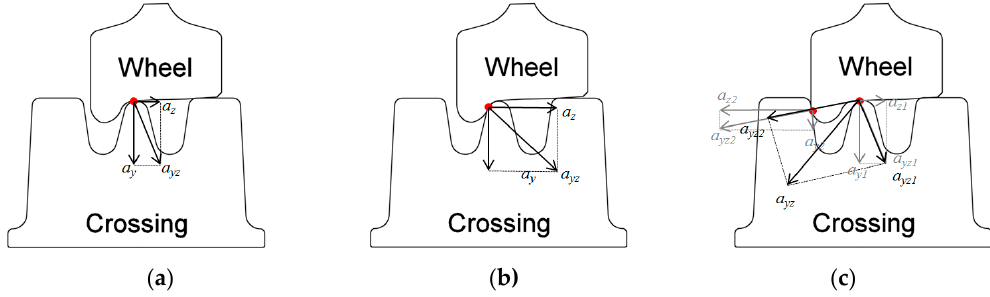
Figure 6. Wheel–rail contact situations: ( a ) regular contact; ( b ) irregular positive contact when wheel flange hits the crossing nose; ( c ) irregular negative contact when wheel flange hits the wing rail.